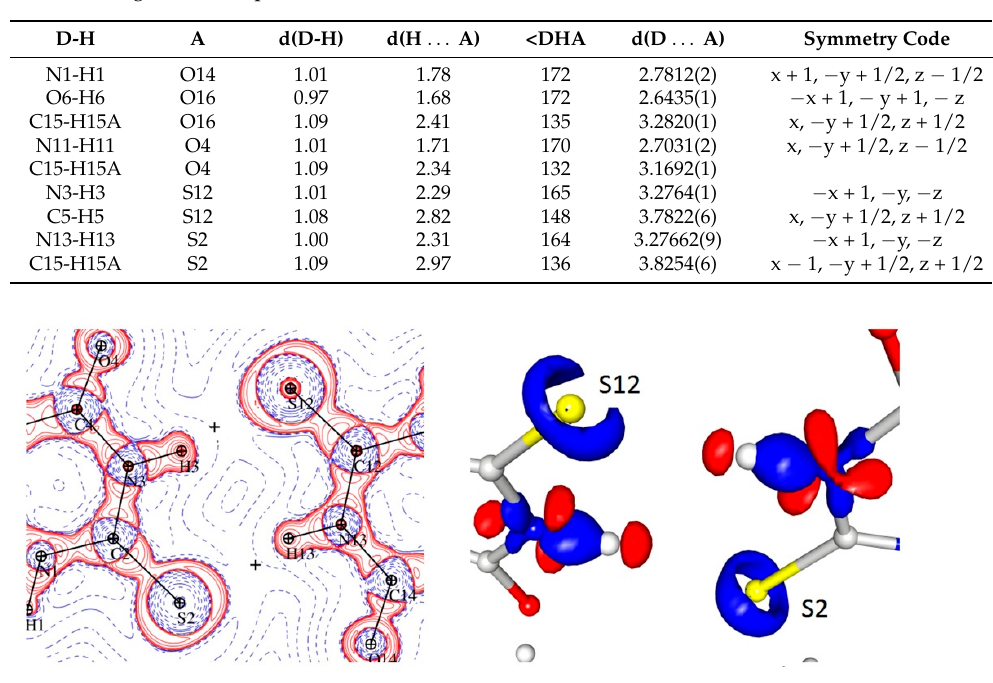
Figure 6. N ‐ H ∙∙∙ S interaction in the Laplacian and 3D map of the static electron density view contour 0.225/ − 0.160 e. Table 5. HB geometrical parameters (Å, °).